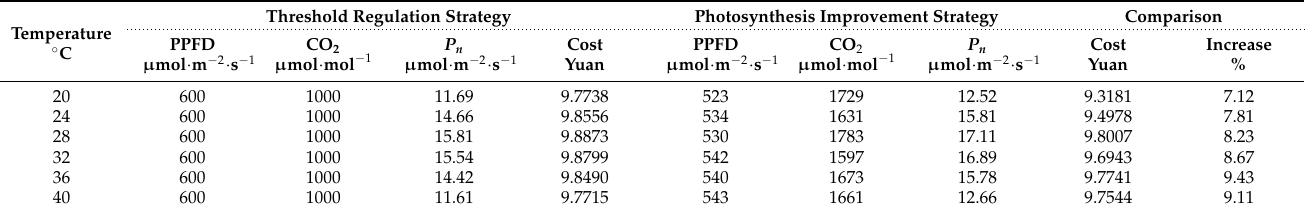
Table 4. Comparison of threshold regulation strategy and photosynthesis improvement strategy.